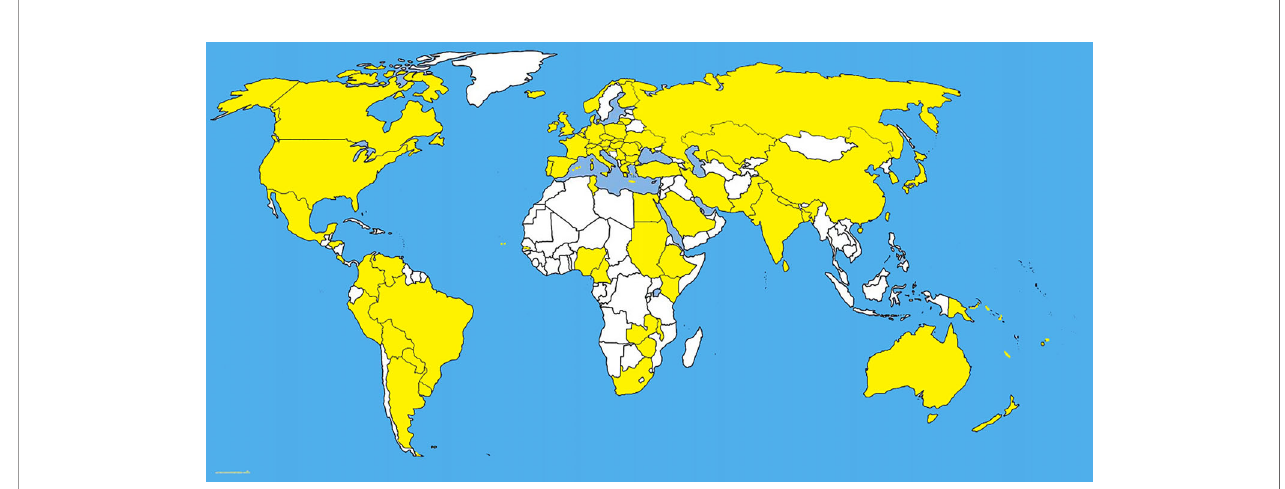
FIGURE 3 | The distribution map of Fusarium graminearum. The areas where infection have been reported are indicated in yellow (www.cabi.org/isc. Accessed on